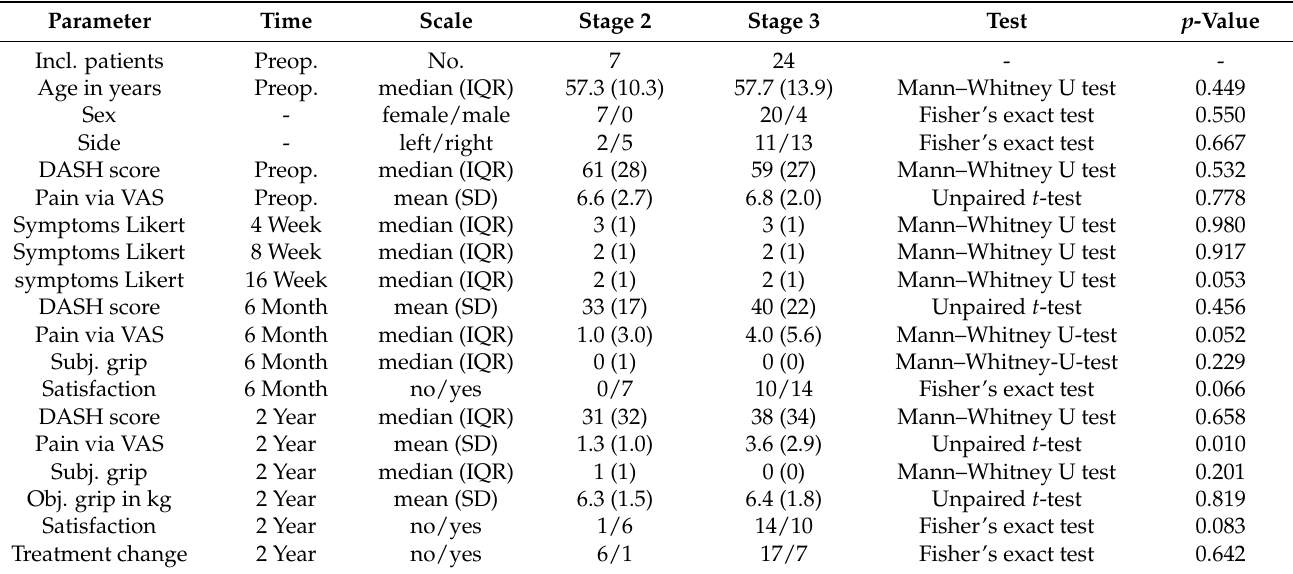
Table 1. Subgroup analysis comparing Stage 2 to Stage 3 osteoarthritis (OA) outcome data. Statistically significant values are printed in